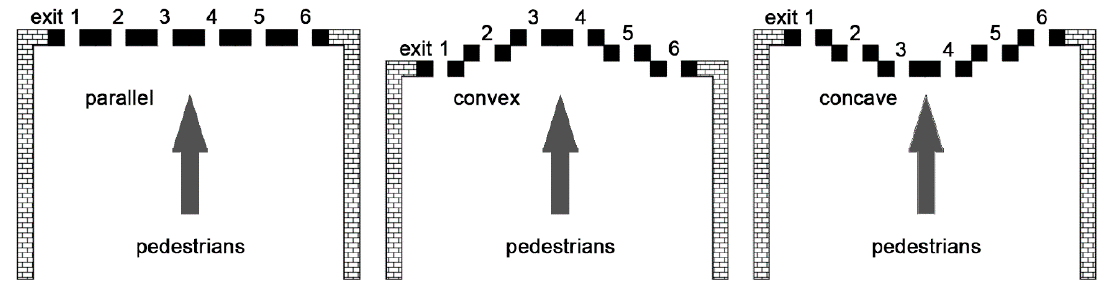
Figure 1. Schematic of the three layouts of multi-exit inspection points: parallel, convex and concave. The inspection machines are shown in black.